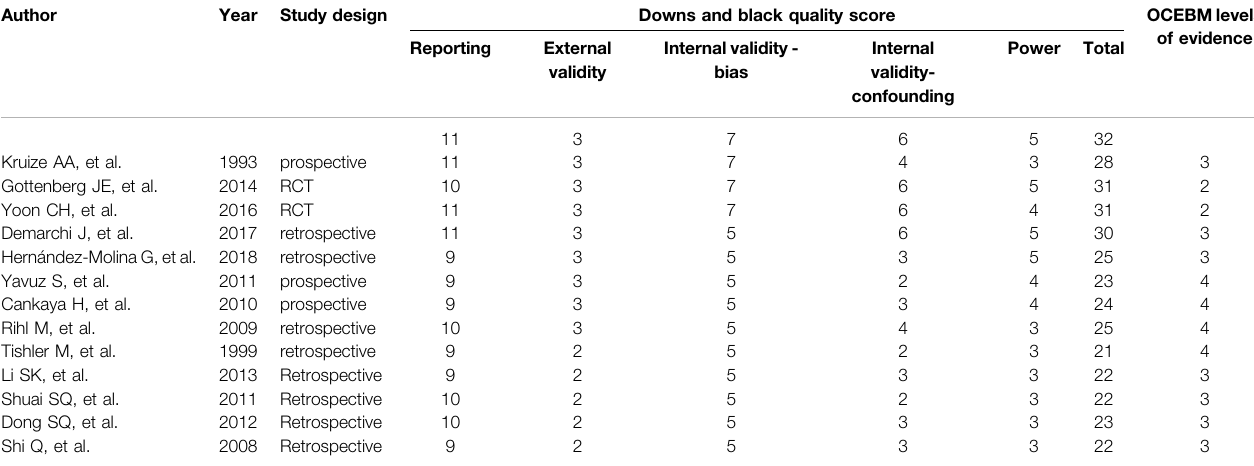
TABLE 2 | Quality assessment of included studies.